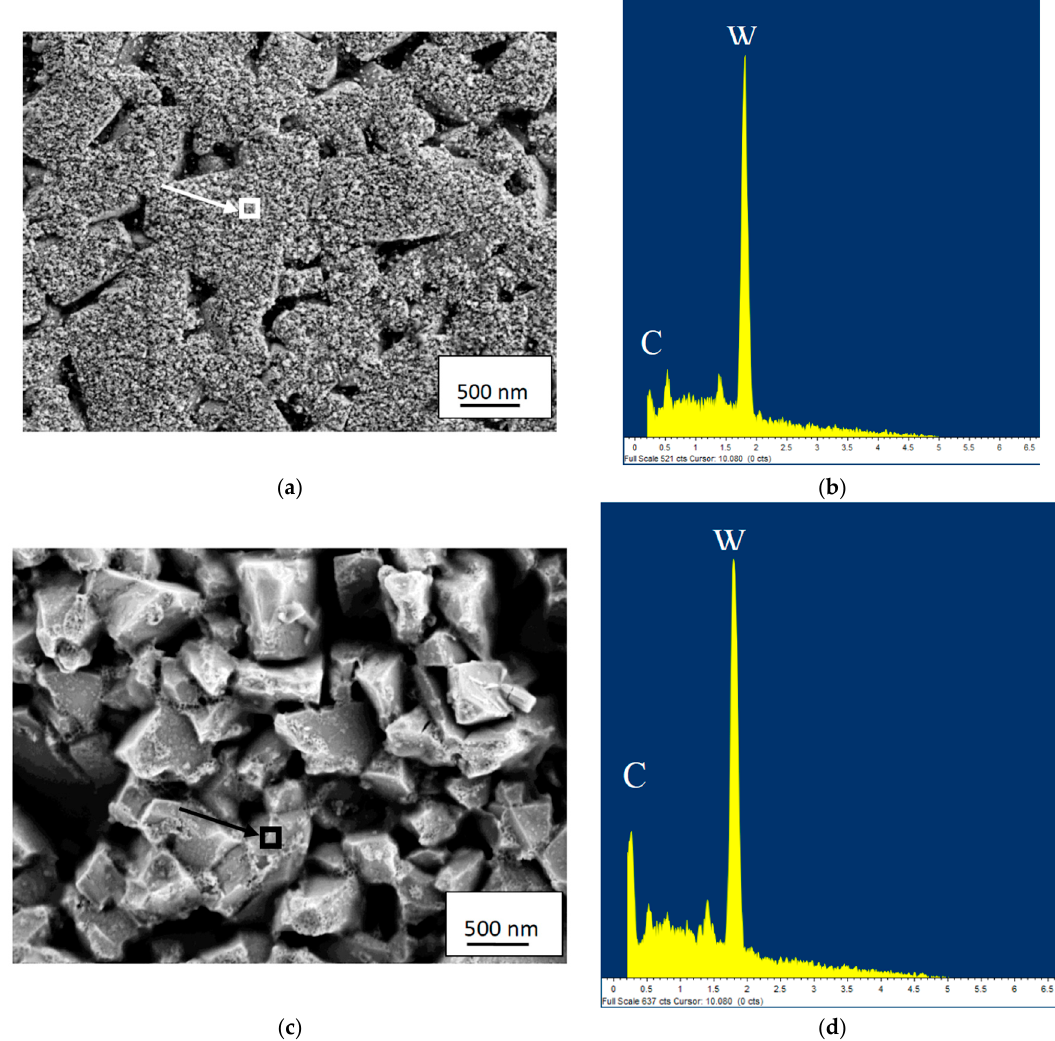
Figure 17. ( a ) Surface morphology of cemented carbide within the crater region showing the presence of a fine grained diffusion layer on the individual WC grains. ( b ) EDS-analysis of the diffusion layer reveals the presence of a WC 1 − x diffusion zone obtained from the indicated area in Figure 17a. ( c ) Surface morphology of WC grains in the crater region but located within a chipping and not in contact with the chip. ( d ) EDS-analysis of the WC grains reveals a high C signal obtained from the indicated area in Figure 17c.